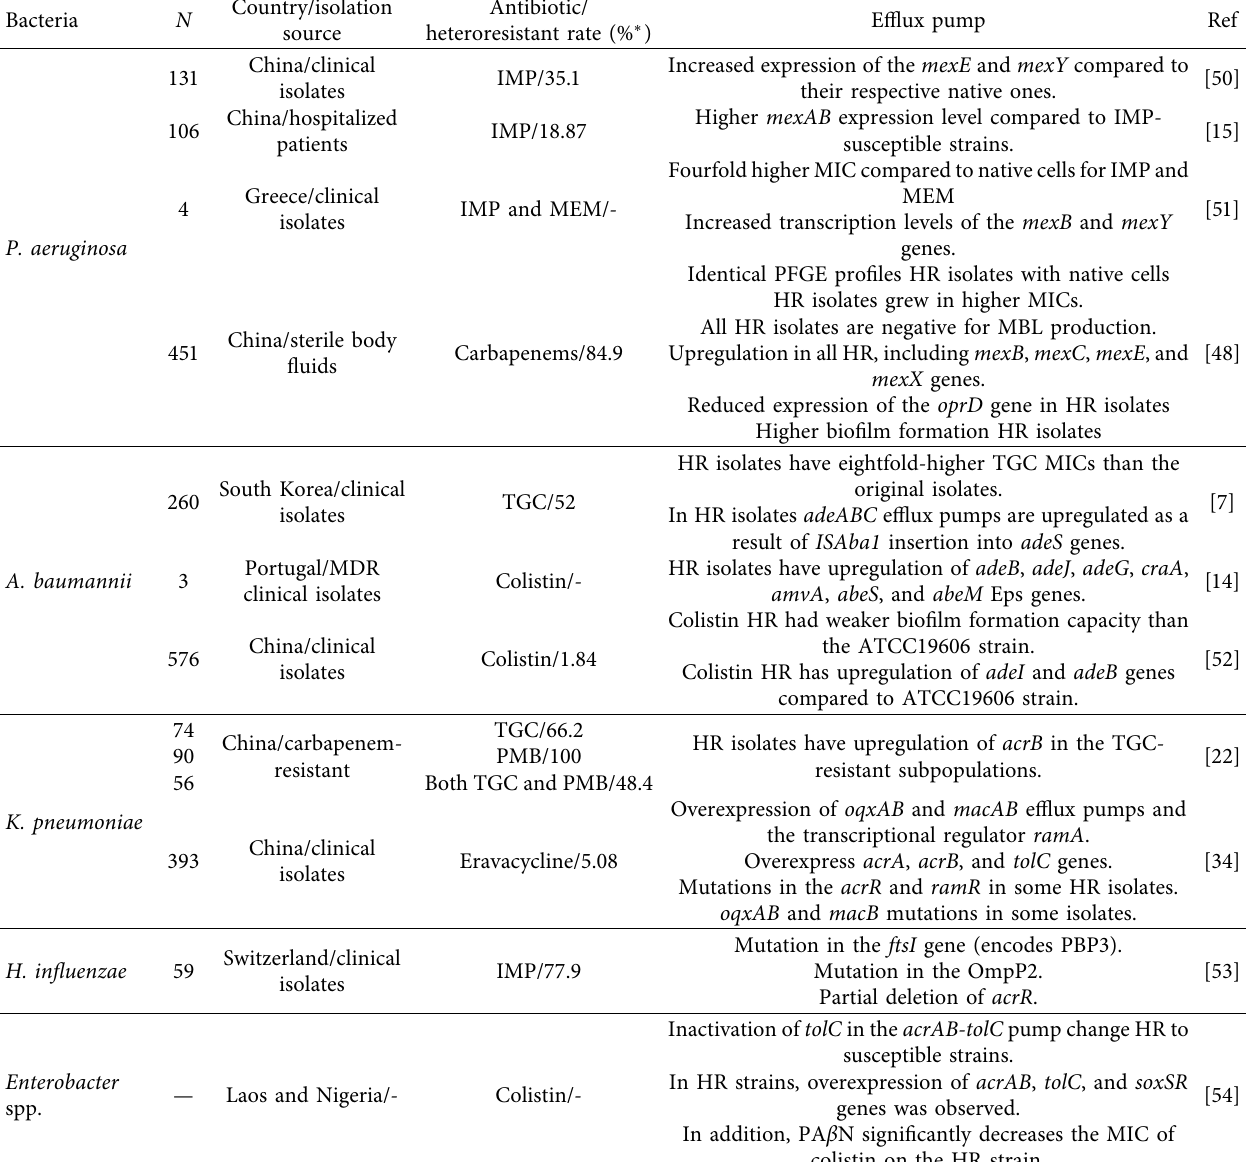
Table 1: HR prevalence among apparently susceptible bacteria strains and observed correlation with overexpression level EPs.